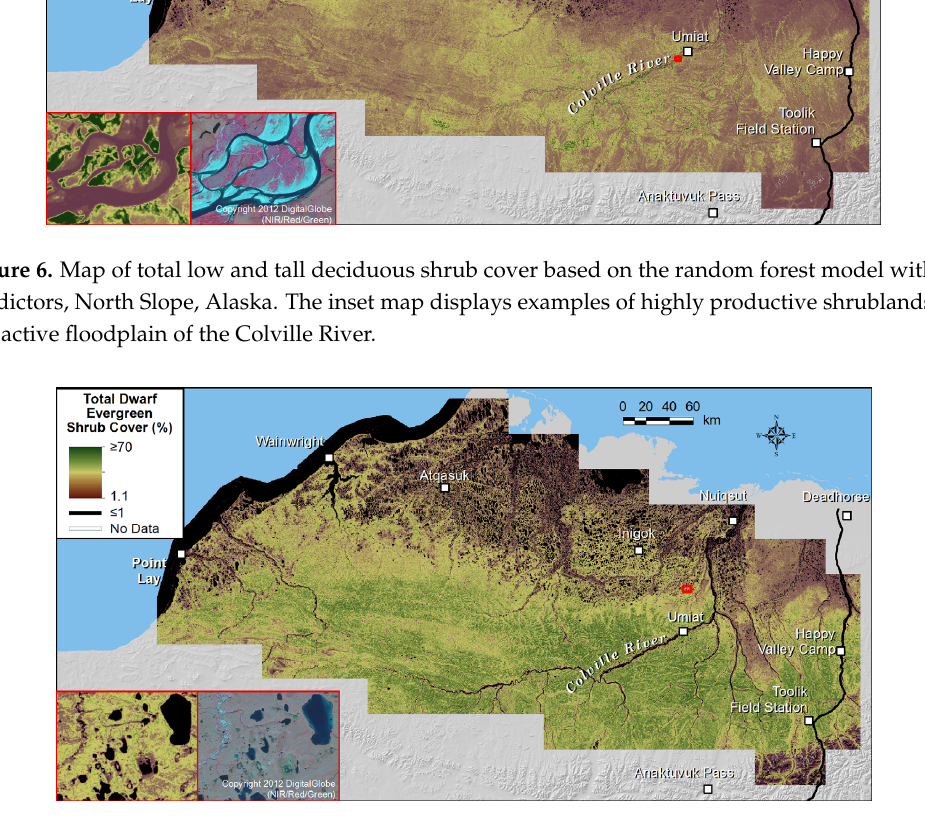
Figure 7. Map of dwarf evergreen shrub cover based on the random forest model with 78 predictors, North Slope, Alaska. The inset map shows an example of dwarf evergreen shrub distribution on the eolian sand sheet region of the coastal plain, where this PFT is common, except in wet areas.